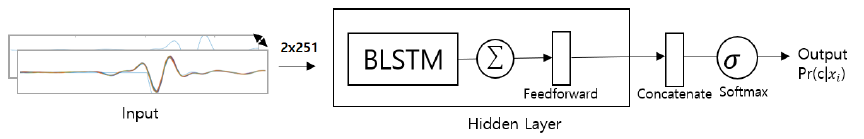
Figure 7. Overview of multi-resolution bi-directional LSTM based system architecture for ECG signal with 250 samples in a